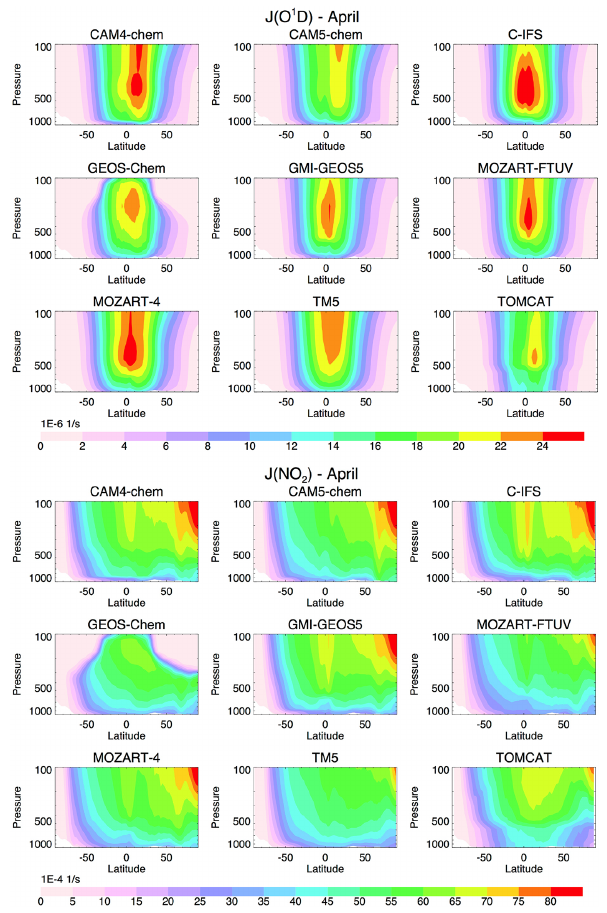
Figure 4. Zonal averages of photolysis rates for each model for April of J (O 3 → O 1 D) (top) and J (NO 2 ) (bottom).